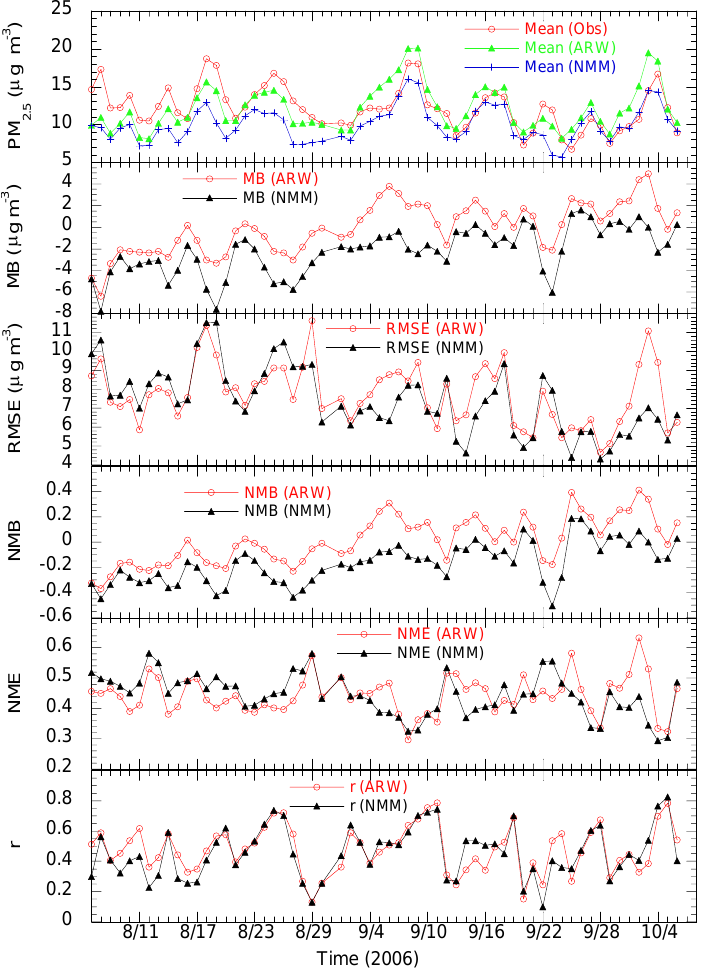
Fig. 2. Comparison of daily variations of the values of domain-wide mean, MB, RMSE, NMB, NME and correlation coefficient ( r ) for the Figure 2. Comparison of daily variations of the values of domain-wide mean, MB, daily PM 2 . 5 mass concentrations at the AIRNow monitoring sites for ARW-CMAQ and NMM-CMAQ RMSE, NMB, NME and correlation coefficient (r) for the daily PM 2.5 mass concentrations at the AIRNow monitoring sites for ARW-CMAQ and NMM- CMAQ simulations.